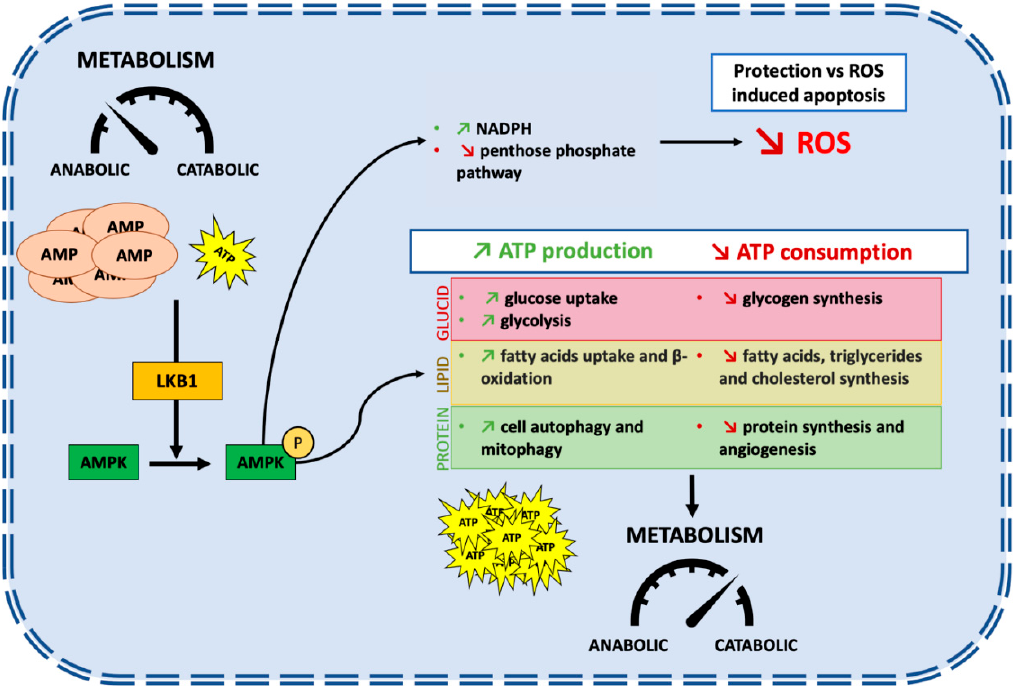
Figure 1. STK11/LBK1 promotes cell survival under stress conditions by allowing a switch from an anabolic to a catabolic metabolism. Under energy deprivation, the accumulation of AMP and the decreased levels of ATP lead to activation of LKB1 which phosphorylate AMPK at Thr-172 in an α subunit resulting in its activation. AMPK is involved in multiple metabolic pathways to increase ATP production and to stop ATP consumption switching metabolism from an anabolic state to a catabolic state. This pathway promotes cell survival under stress conditions but impairs cell growth and